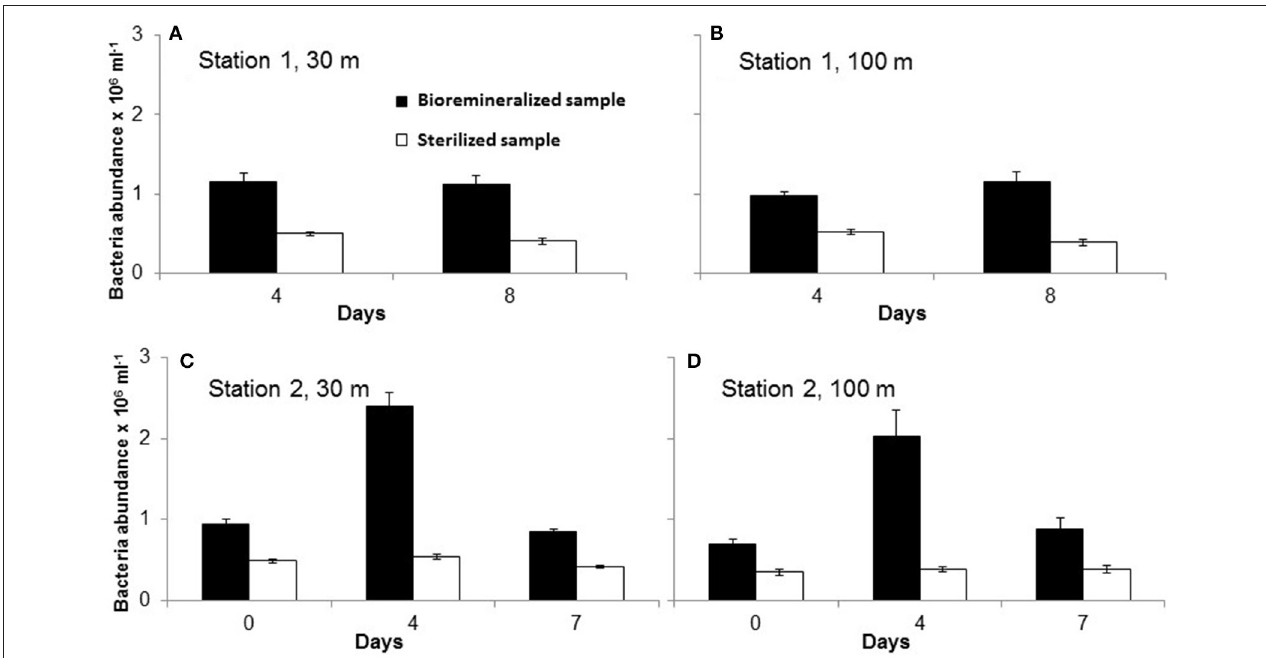
FIGURE 3 | Abundance of bacteria counted in samples at different during the particle reminera lization experiment in unsterilized (filled black bars) and sterilized (unfilled bars) samples from 30m (A,C) and 100m (B,D) of station 1 (A,B) and Station 2 (C,D). Note that for station 1 day-0 samples were not measured due to instrument issues.